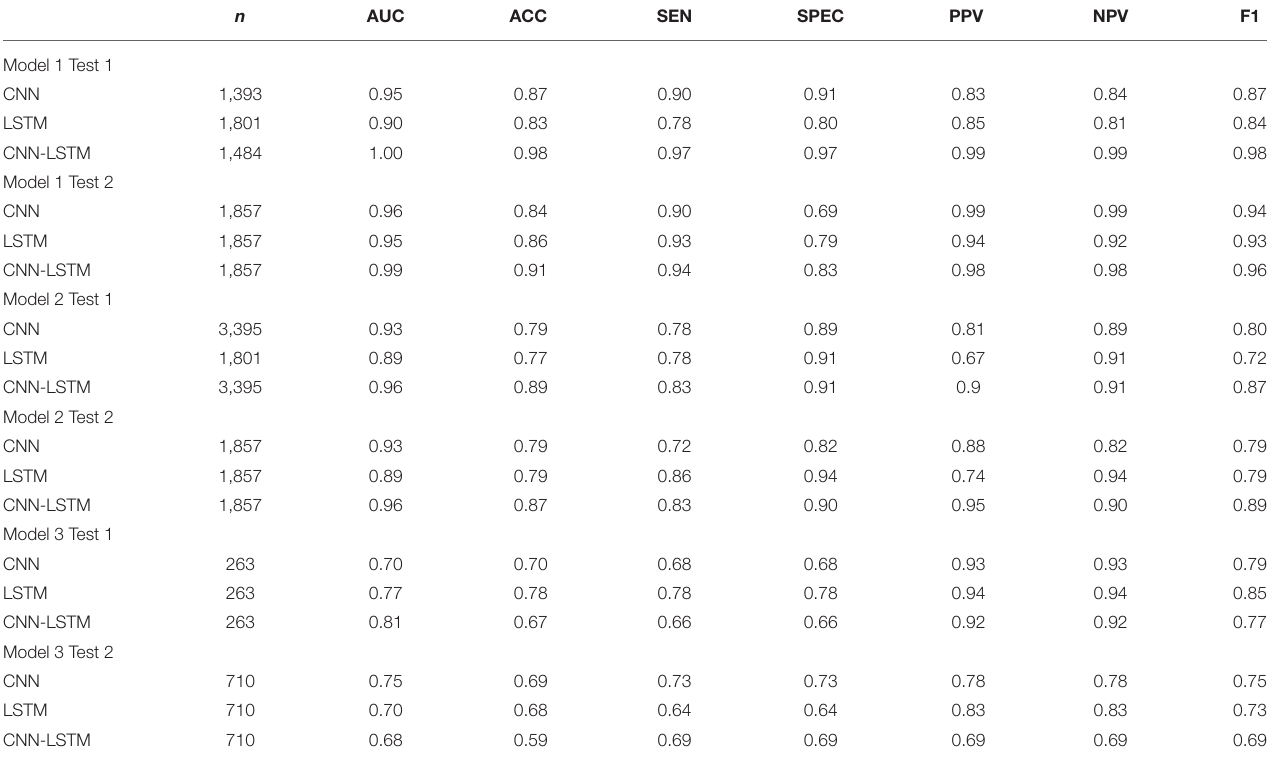
TABLE 2 | Diagnostic performance of CNN-LSTM, CNN, LSTM, and doctors in different datasets. n AUC ACC SEN SPEC PPV NPV